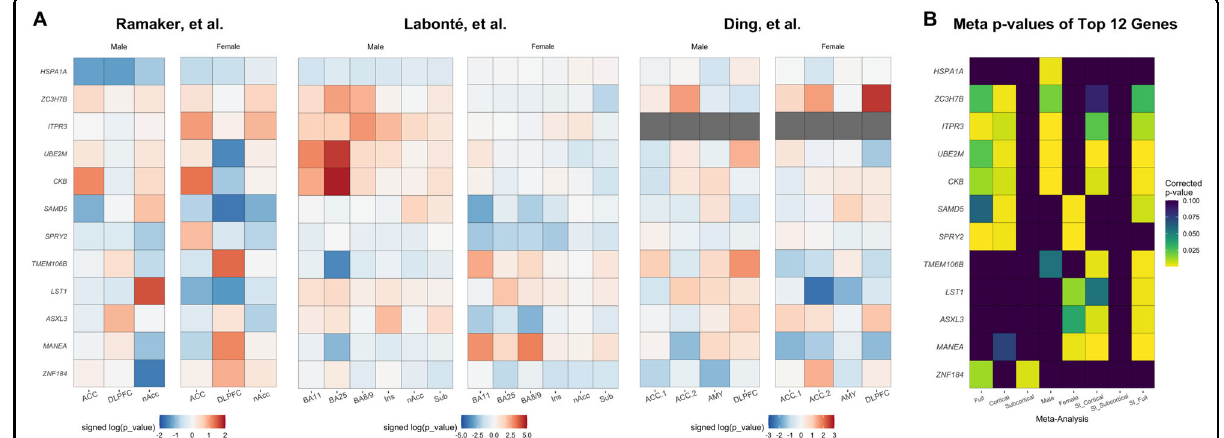
Fig. 2 Heatmap visualizations of differential expression results. a Study-speci fi c direction signed log( p -values) for the top 12 genes separated by sex and region. Cell colours range from blue to red, which represents lower and higher expression in cases compared to controls, respectively. Colour intensity represents the degree of differential expression. Missing values are marked in gray. b Corrected meta p -values for the same genes across the 8 across-study meta-analyses. Cell colours range from low (yellow) to high (purple) corrected p -values in each meta-analysis. ACC anterior cingulate cortex (two studies) , DLPFC dorsal lateral prefrontal cortex , nAcc nucleus accumbens , Ins anterior insula , Sub subiculum , AMY amygdala, SI sex